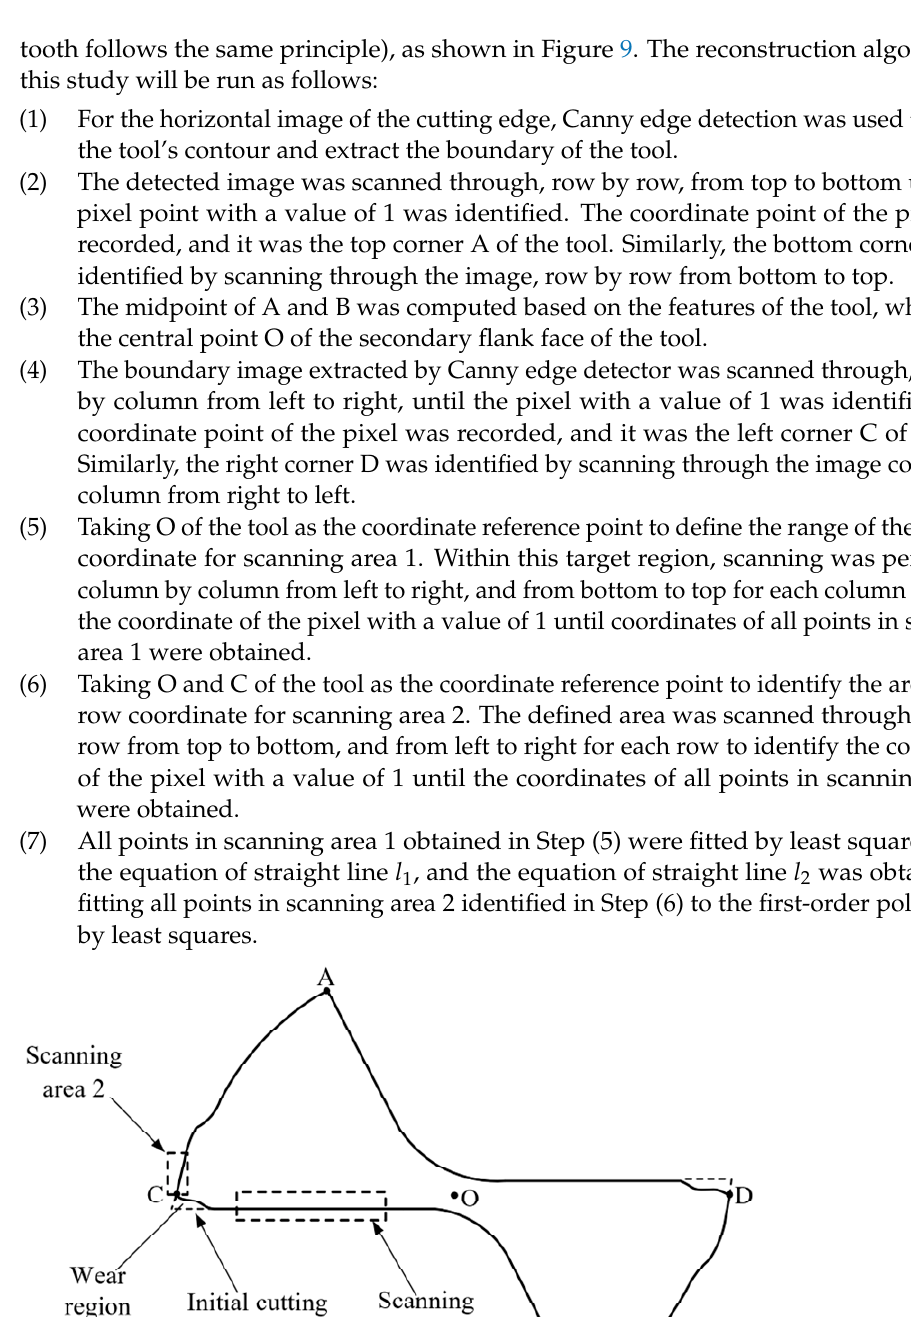
Figure 8. Principle of Hough transform in detection of straight lines.